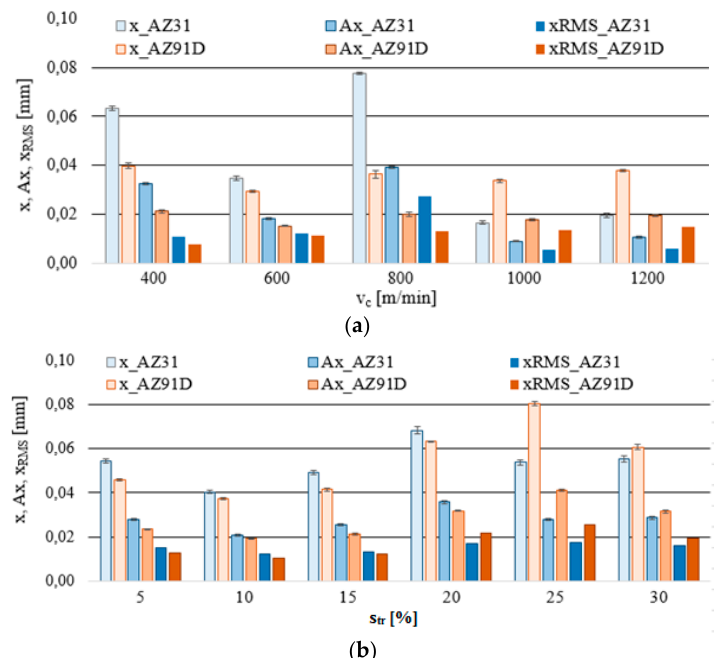
Figure 9. Maximum value of vibrations displacement, amplitude and RMS in the milling of magnesium alloys: ( a ) effect of cutting speed v c (f z = 0.15 mm/tooth, a p = 6 mm and s tr = 15%) and ( b ) effect of trochoidal step s tr (v c = 800 m/min, f z = 0.15 mm/tooth and a p = 6 mm).